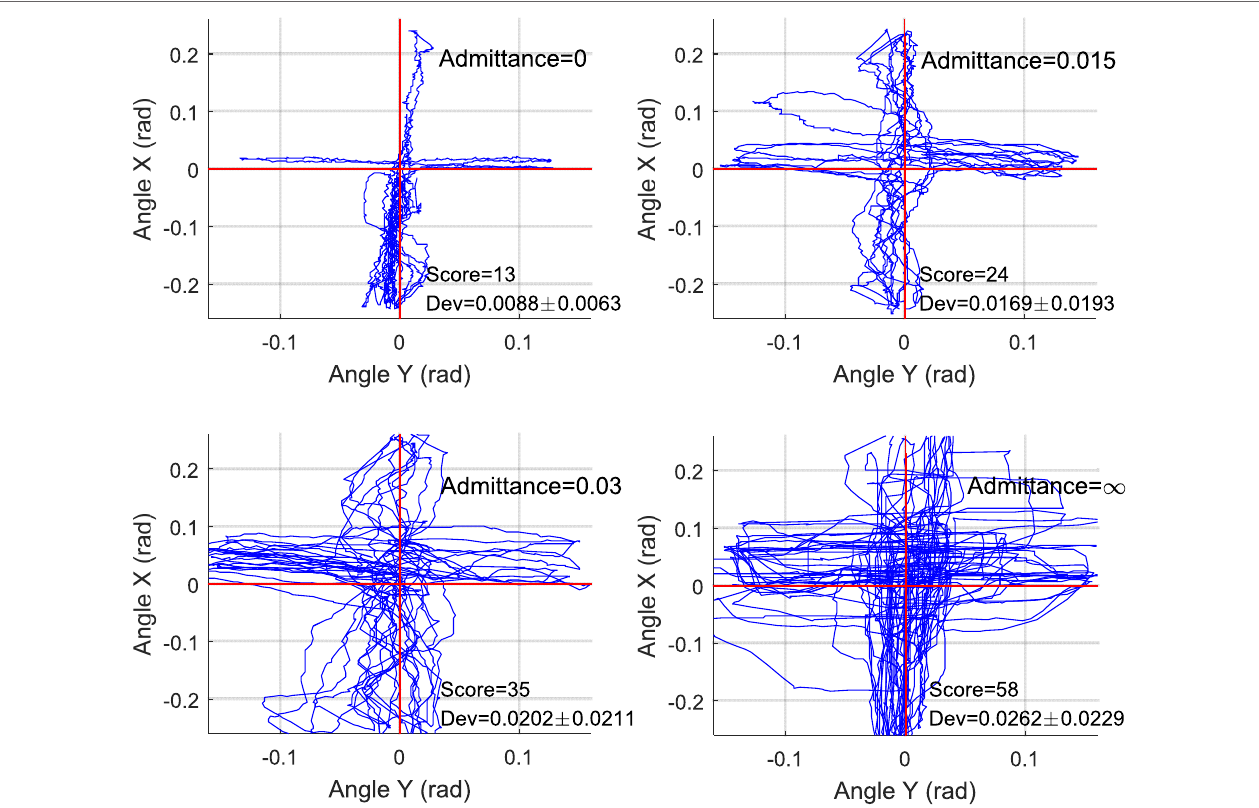
FIGURE 11 | Target reach game-guided movement training results with adjustable end-effector admittance, in which red line the reference and blue is the actual